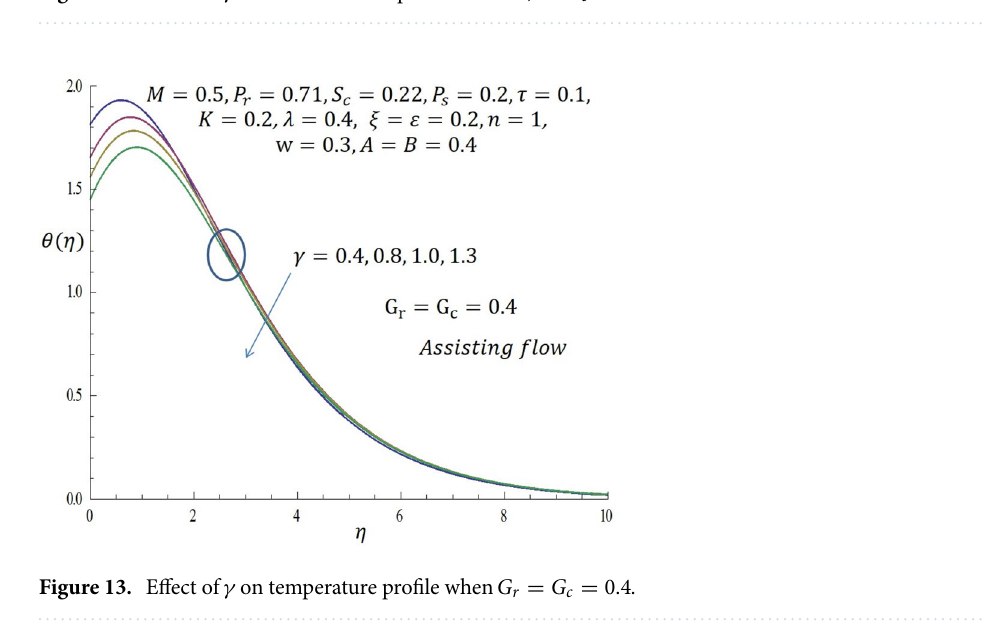
Figure 12. Effect of γ on concentration profile when G r = G c = 0.5.